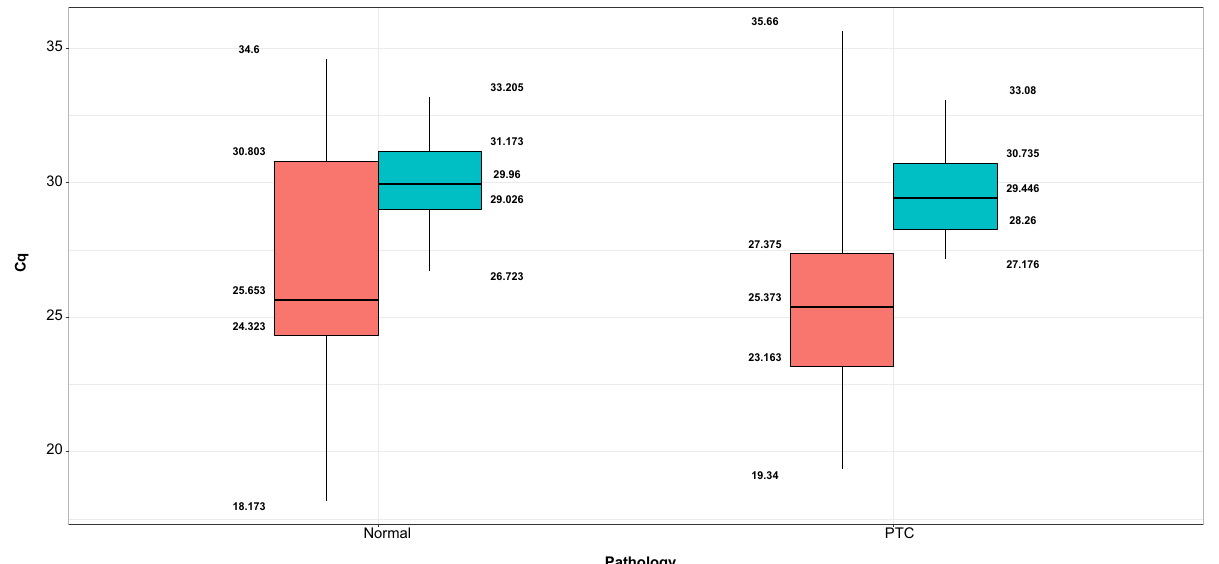
Figure 3. Expression of SYMPK and GAPDH in normal and PTC tissues. In normal tissues, SYMPK (blue bars) exhibited a smaller range of Cq values than GAPDH (red bars), and this was also true in PTC tissues, where SYMPK had less variance.